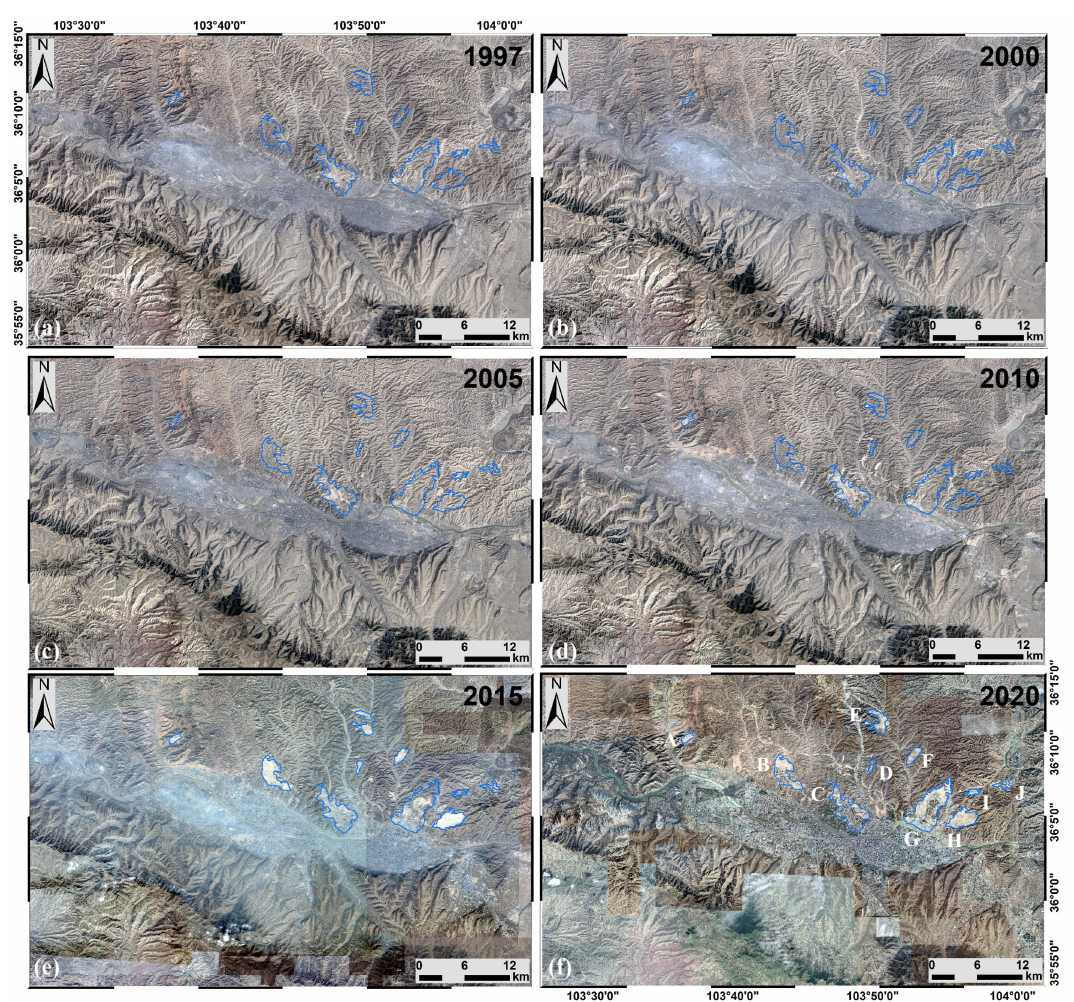
Figure 2. Optical remote sensing images of the city of Lanzhou at different time periods (( a )—in 1997, ( b )—in 2000, ( c )—in 2005, ( d )—in 2010, ( e )—in 2015, and ( f )—in 2020), where the blue lines represent the regions of ten large-scale mountain excavation and land